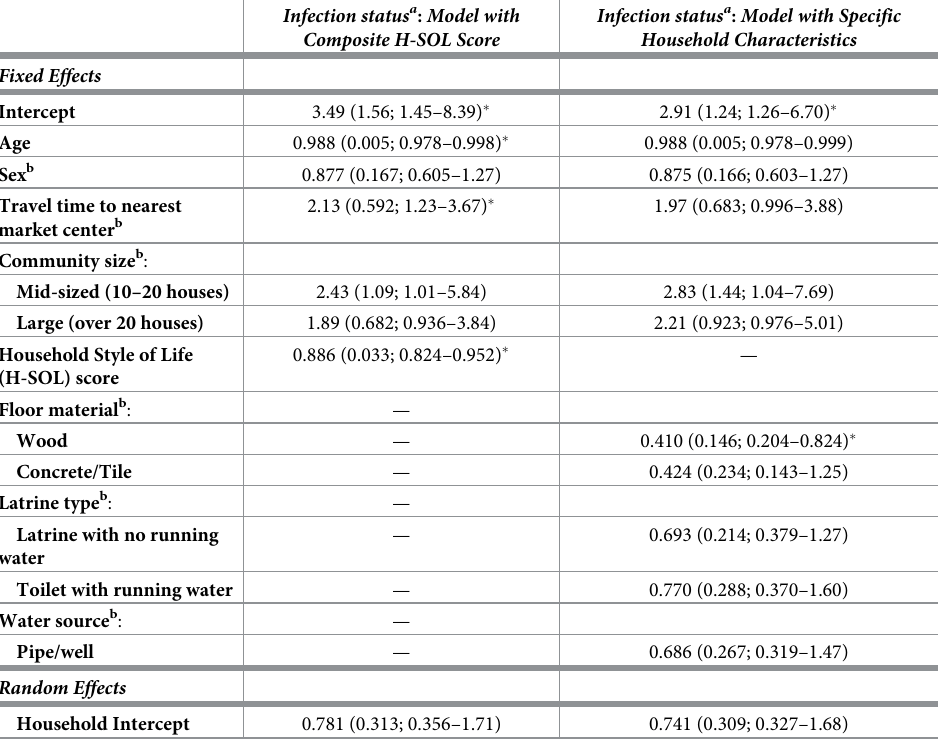
Table 3. Associations between household characteristics and infection